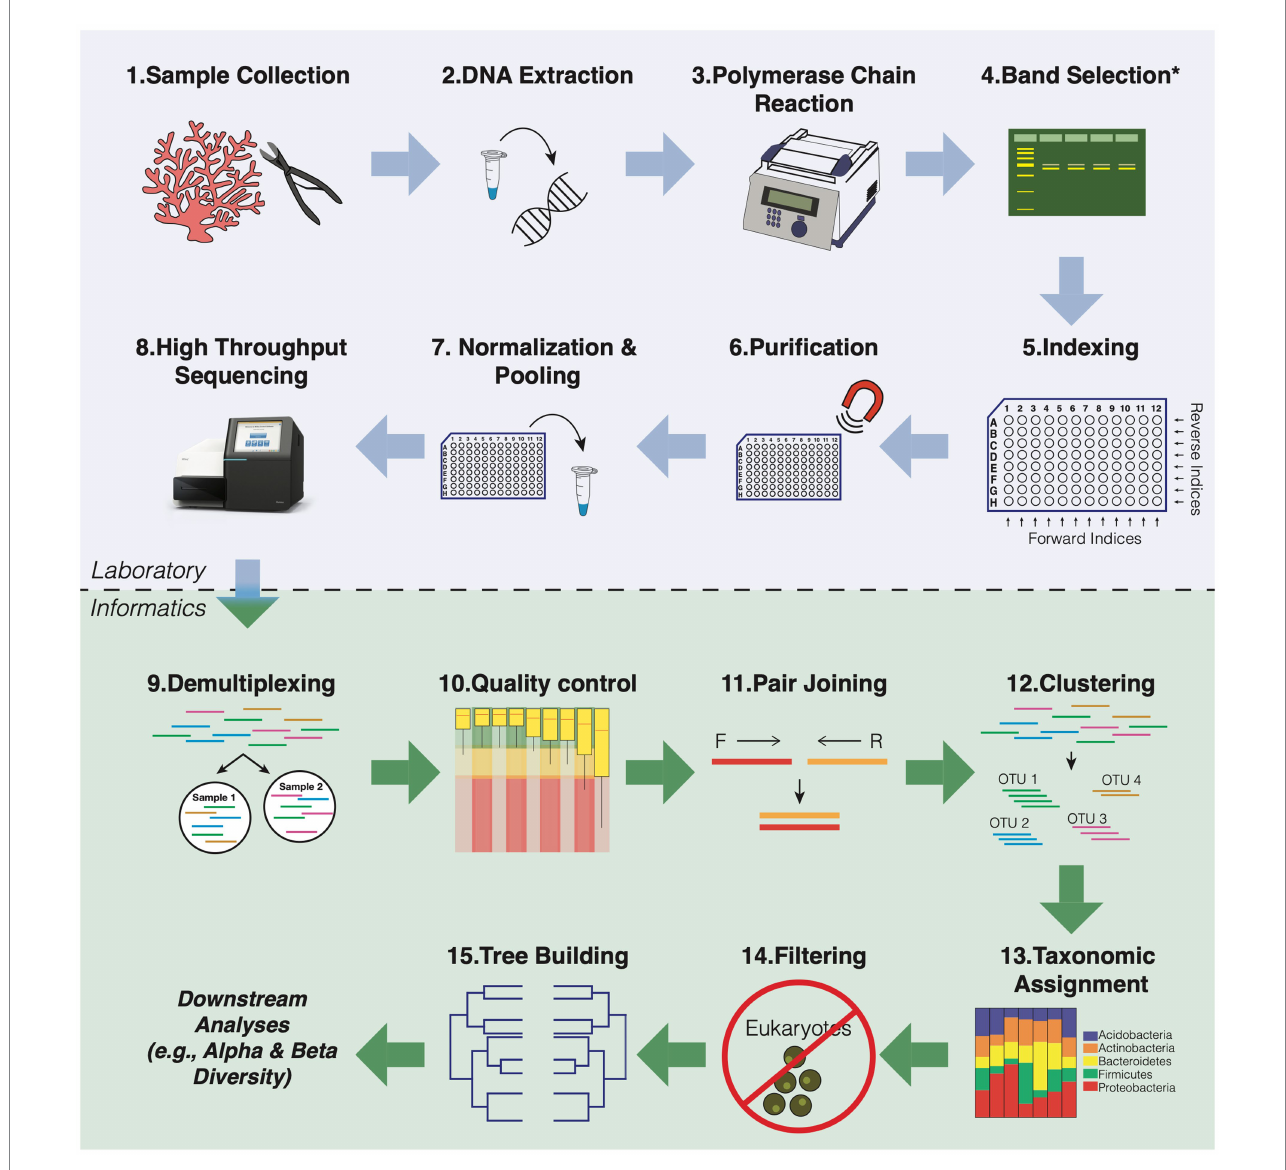
FIGURE 3 General workflow overview for 16S rRNA amplicon sequencing of coral microbial communities. The blue box indicates all the steps for preparing the library. The green box shows all the steps of bioinformatic data analysis that refer to the preparation of the readings for the downstream